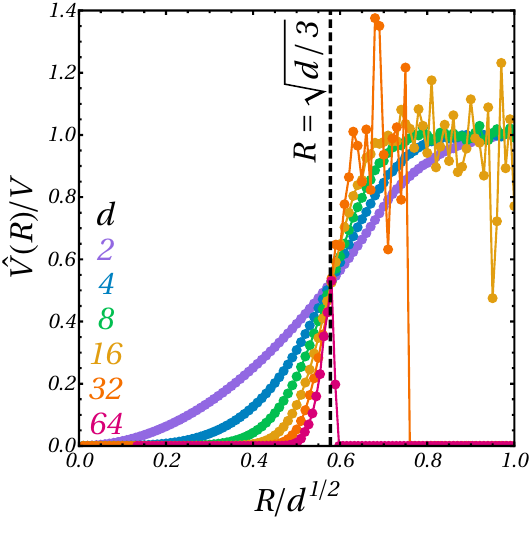
Figure 3: Na¨ıve random sampling shortcomings. Direct Monte Carlo evaluation ˆ V ( R ) of the volume of a hy- percube with actual volume V , using N s = 10 5 points uniformly drawn from a hyperball with radius R , for di- mensions going from 2 to 64. Here the half-sidelength of the hypercube is a = 1. The dashed line indicates the asymptotic mode of the mass distribution of the (cid:112) cube, d/